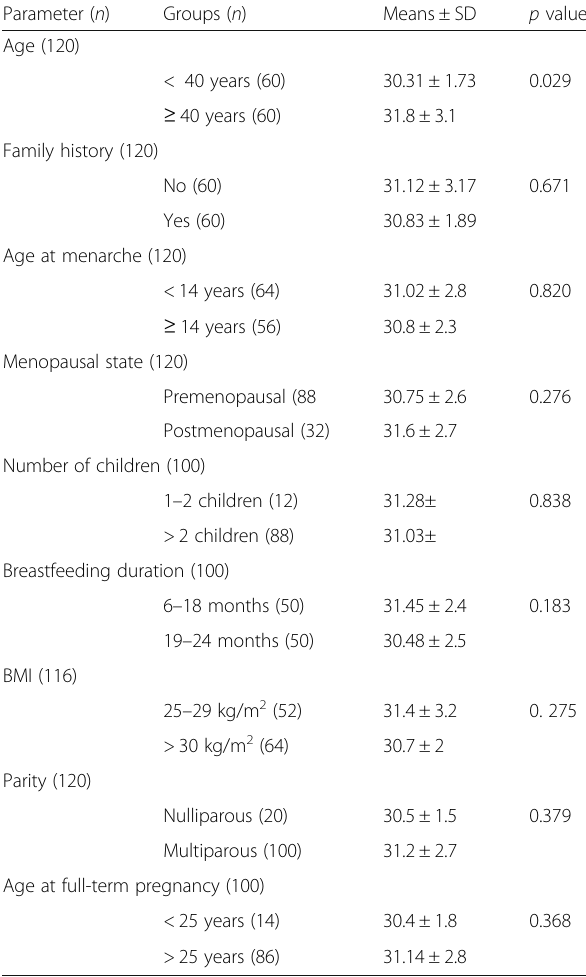
Table 2 Methylation percentage of p14/ARF gene among the studied subgroups of breast cancer risk